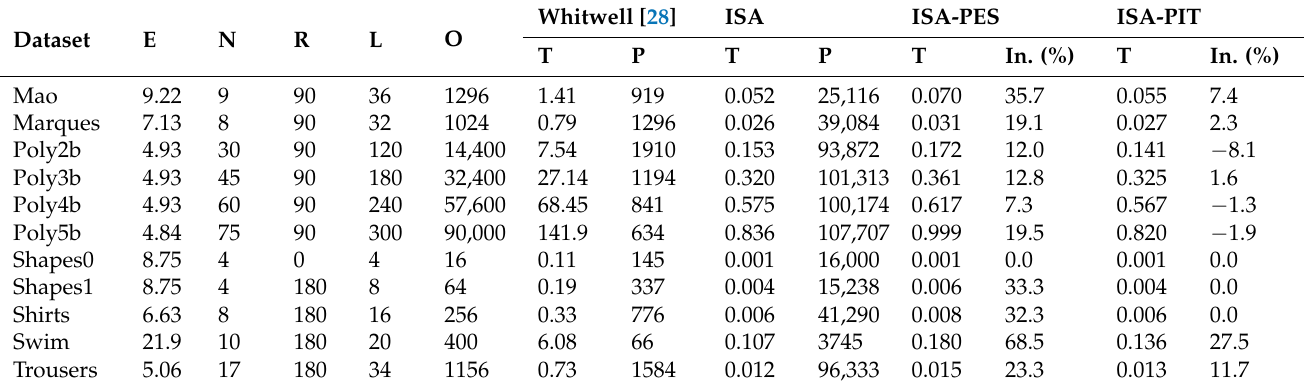
Table 1. No-fit polygon creation times for 19 datasets from the literature.